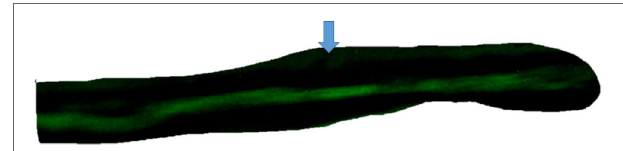
FigUre 1 | Top – absence of intercellular diffusion of fluorescent glucose in single cell pair exposed to aldosterone (100 nM) for 24 h . Arrow indicates site of micropipette filled with